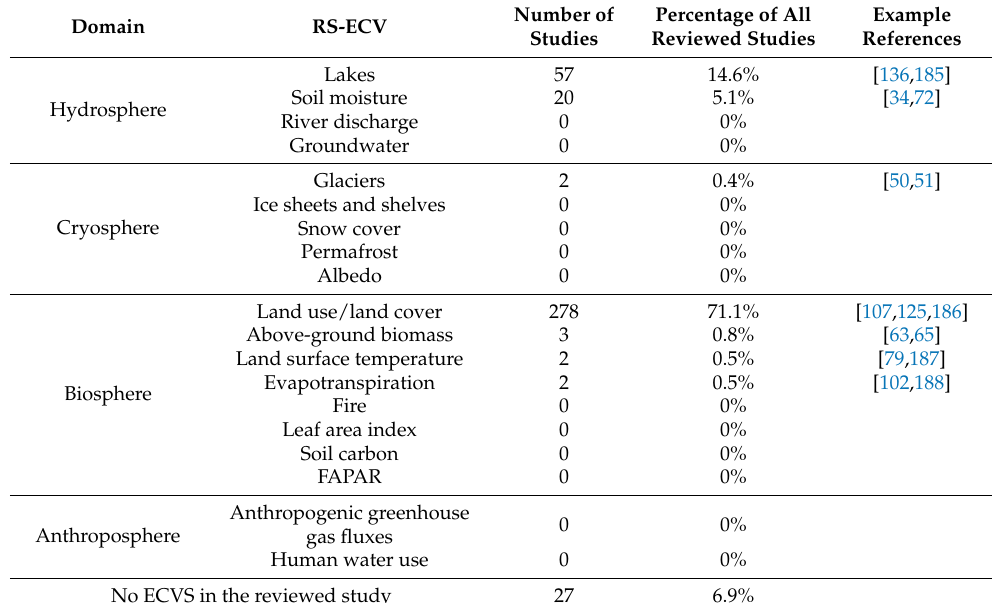
Table 4. Number and percentage of reviewed studies by remote sensing essential climate variable (RS-ECV) as defined by GCOS (2010) [184]. The total number of studies exceeds 351 because some studies mentioned several ECVs. FAPAR: Fraction of absorbed photosynthetically active